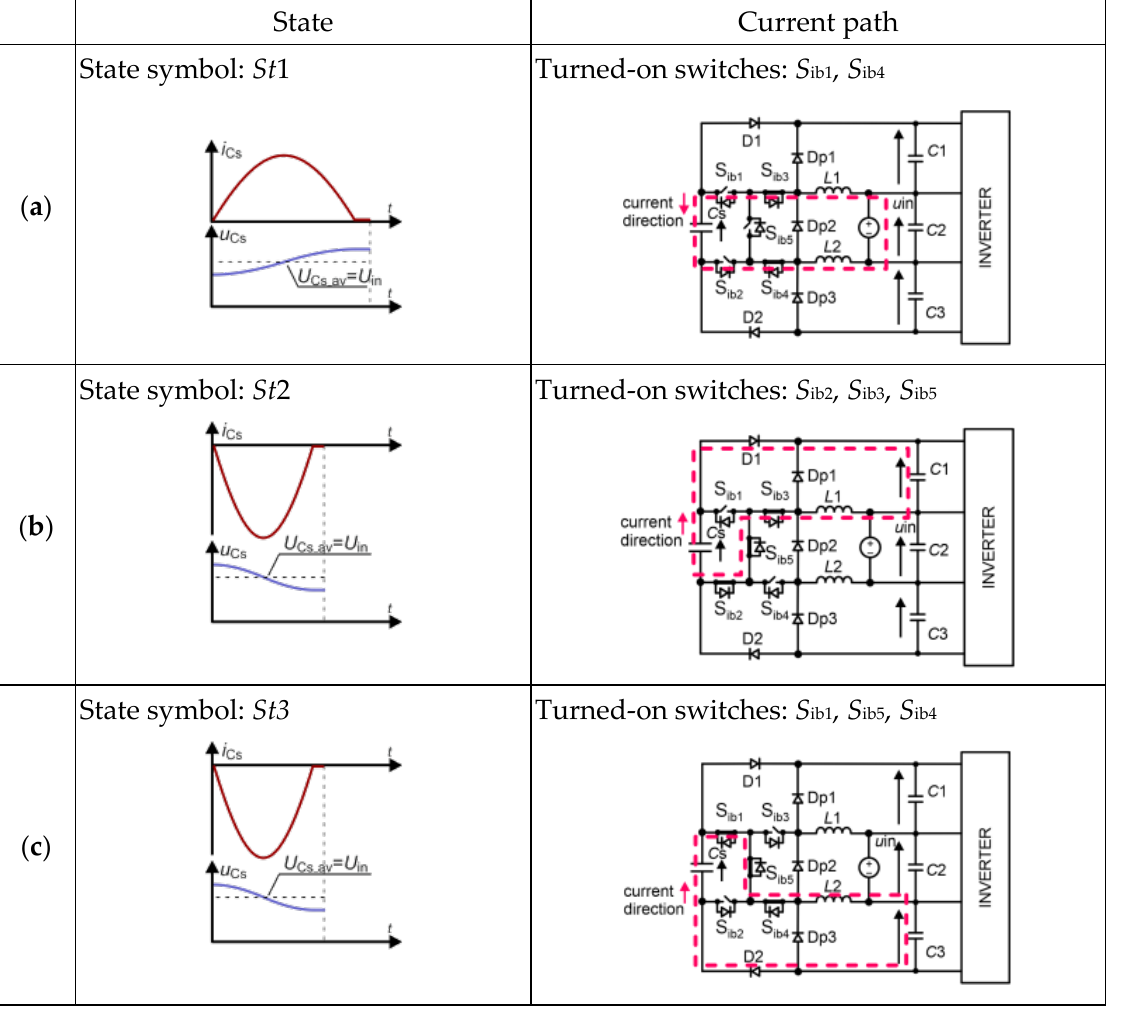
Figure 3. The principle of energy transfer to the DC-link capacitors C 1 and C 3 from the source of energy by the AIVB. Idealized waveforms of switched capacitor voltage ( u Cs ) during its charging ( a ) and discharging ( b , c ) as well as oscillatory current of the switched capacitor and marked compo- nents ( i Cs ).